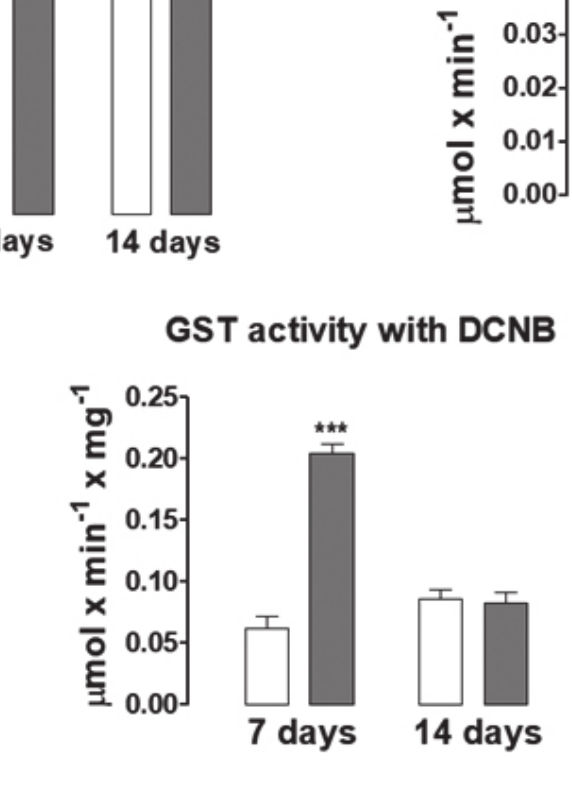
FIGURE 3 | GST specific activities in liver cytosol from Piaractus mesopotamicus injected with benzo[a]pyrene (15 mg kg -1 ). Assays were carried out with 1-chloro-2,4-dinitrobenzene (CDNB), ethacrynic acid (ETHA) or 2-dichloro-4-nitrobenzene (DCNB) 7 and 14 days after the injection. Bars represent the means ± S.E.M. of assays from nine fish injected with corn oil (clear) or benzo[a]pyrene (dark grey). Significant different from controls are indicated as ***(P <